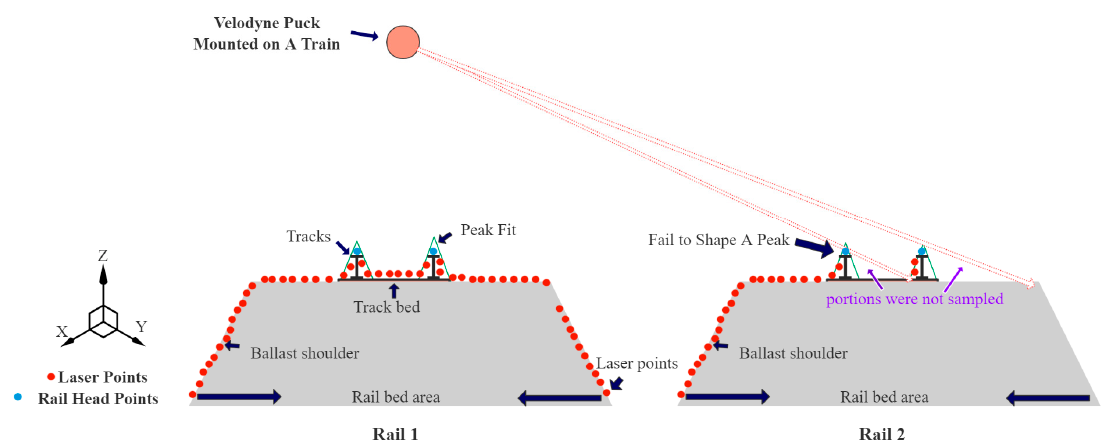
Figure 15. Failure at some portions caused by occlusion.